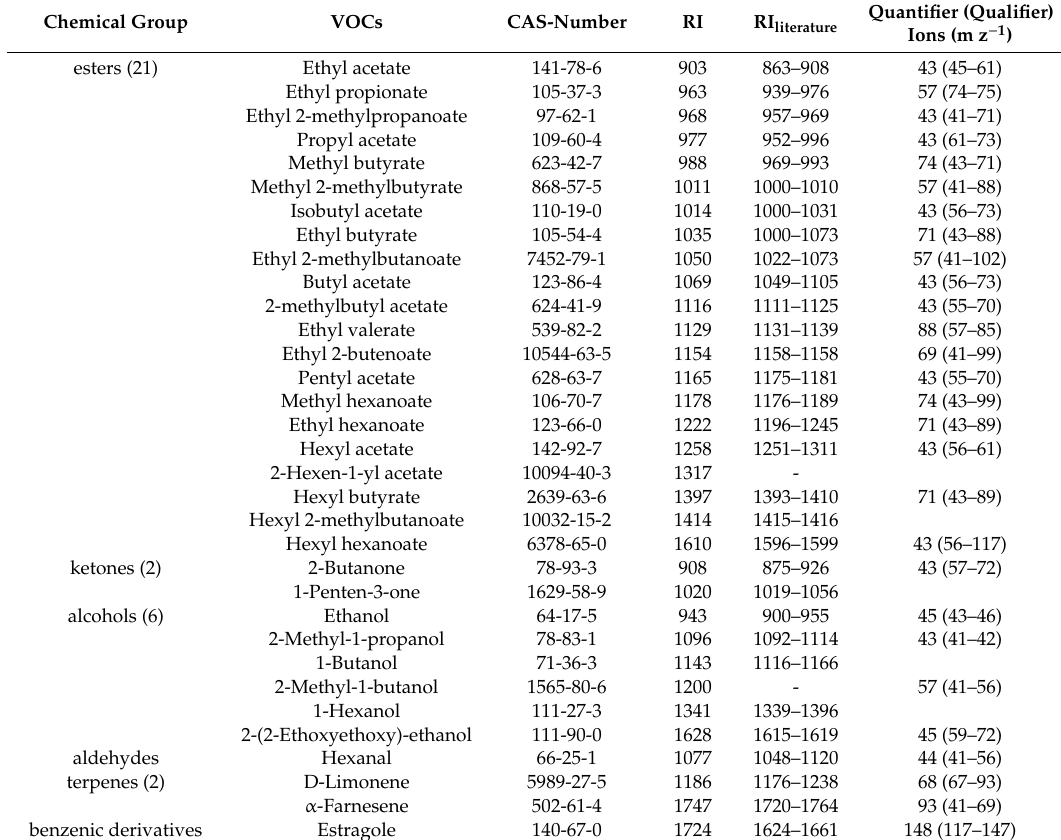
Table 1. All identified volatile organic compounds (VOCs) emitted by intact, freshly cut and variously treated (sHWT / chemical prevention) fresh-cut apple slices as characterized by their CAS registry numbers, calculated retention indices (RI), previously reported retention indexes (RI literature ), and quantifier and qualifier ions used for peak